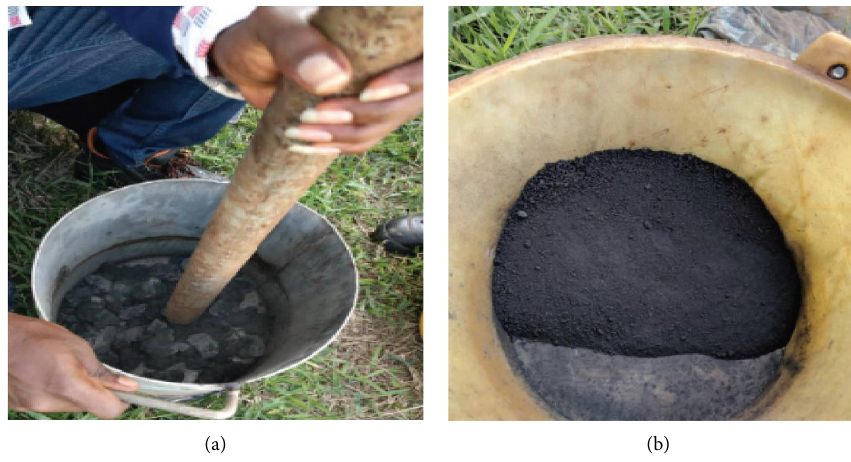
Figure 2: (a) Grounding of biochar. (b) Sieved biochar.